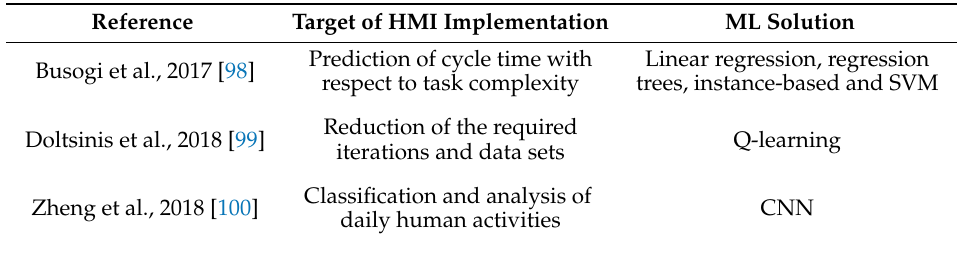
Table 6. Target of Human–Machine Interaction (HMI) implementations and respective ML solutions for Industry